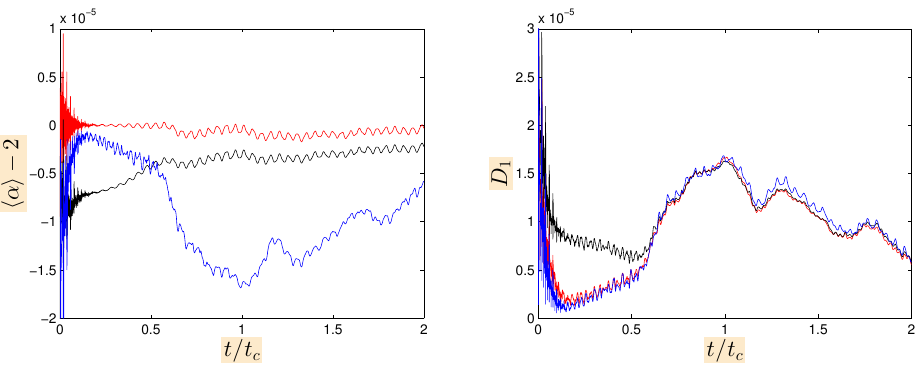
Figure 7. Double shear layer. The grid resolution is 256 × 256, Ma = 0.0693, Re = 3 × 10 4 . The time histories of the variables (cid:104) α (cid:105) − 2 and D 1 are presented; the low-dissipative entropic method is denoted by a red line ( − ) ; the third-order EELB method is denoted by a black line ( − ) ; the method of Zhao and Yong is denoted by a blue line ( − )